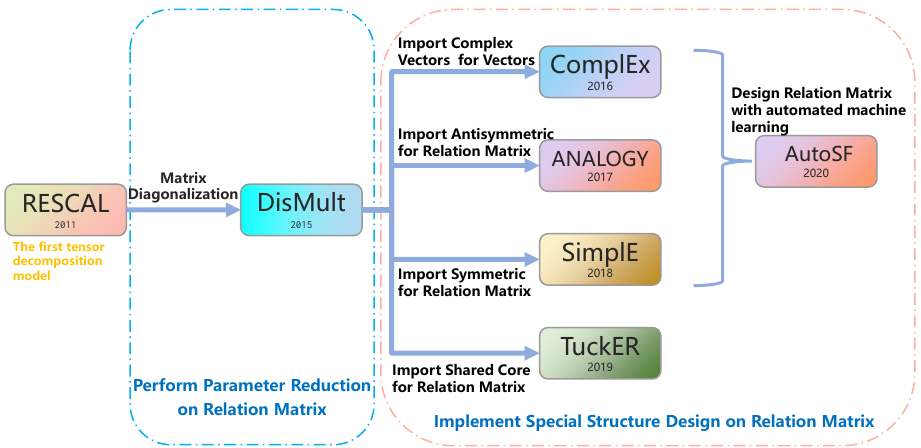
Figure 2. The research routes of current tensor decomposition models.